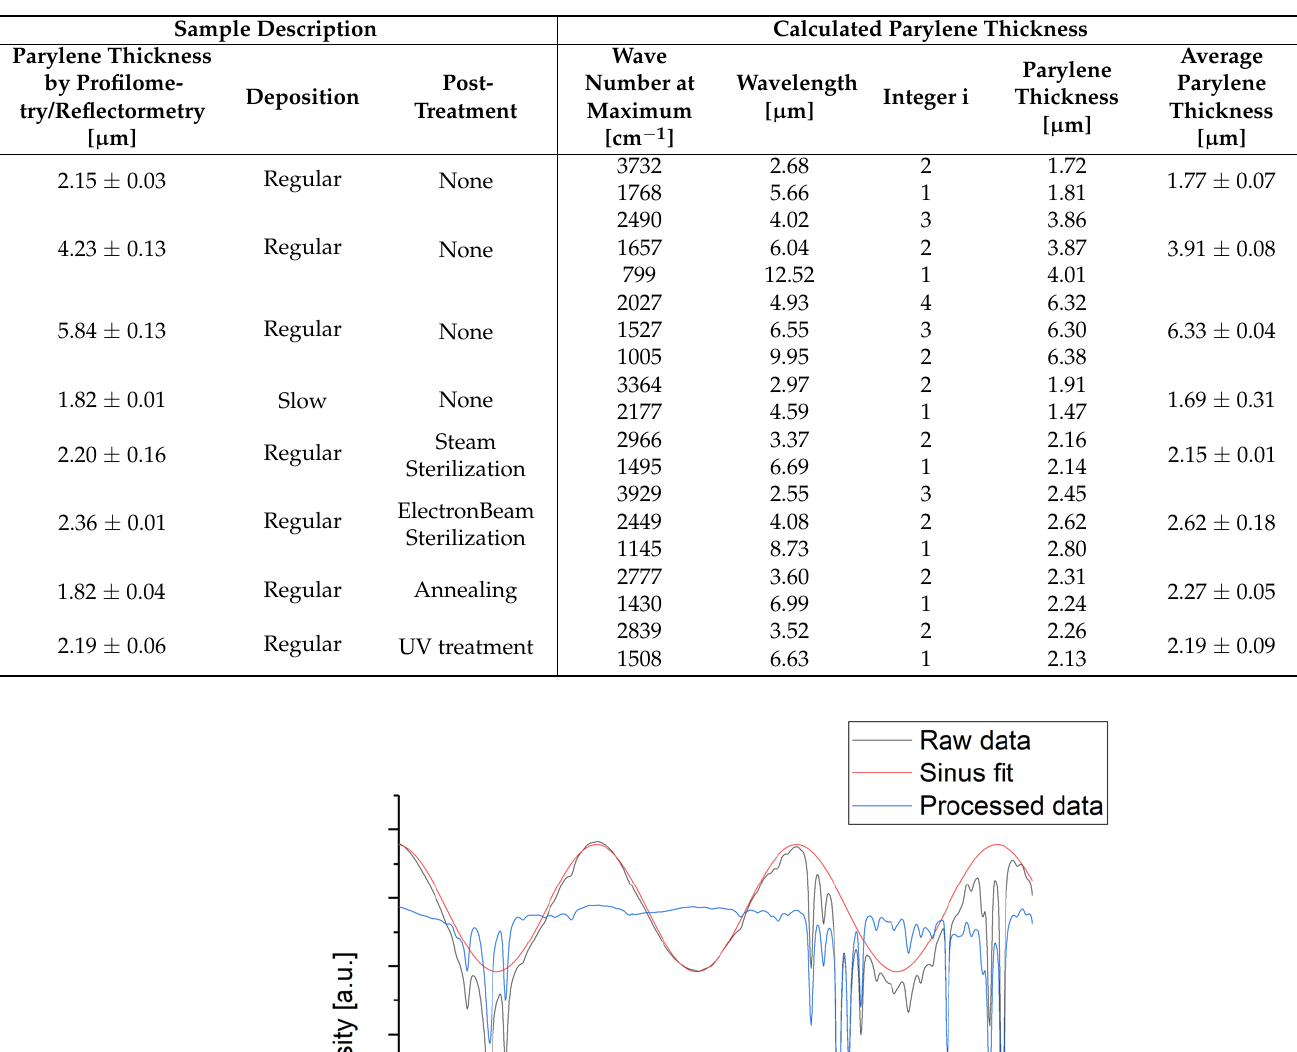
Table A1. Comparison of Parylene thicknesses calculated by assuming constructive interference according to Equation (2) in the measured FTIR spectra and the Parylene thicknesses measured by profilometry and reflectometry, respectively. For the calculation, a refractive index of n = 1.56 was used.